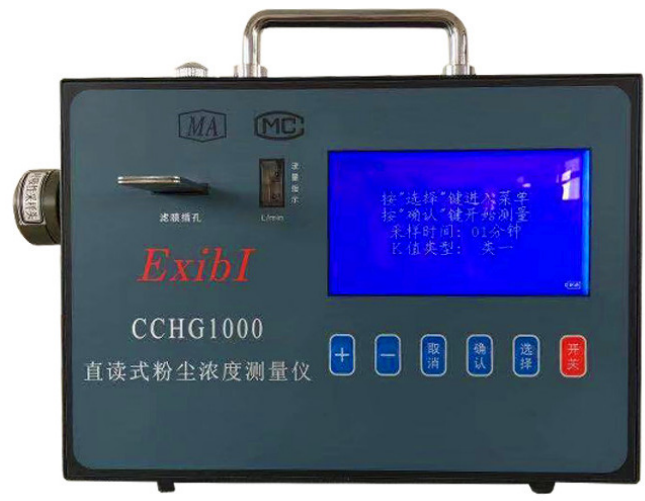
Figure 11. Dust-measuring device.